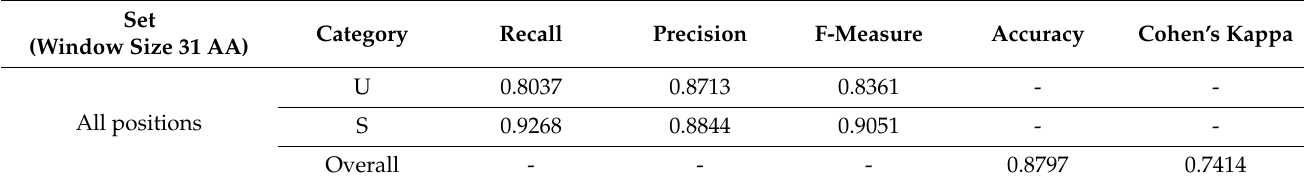
Table 3. The statistic of the LR model after